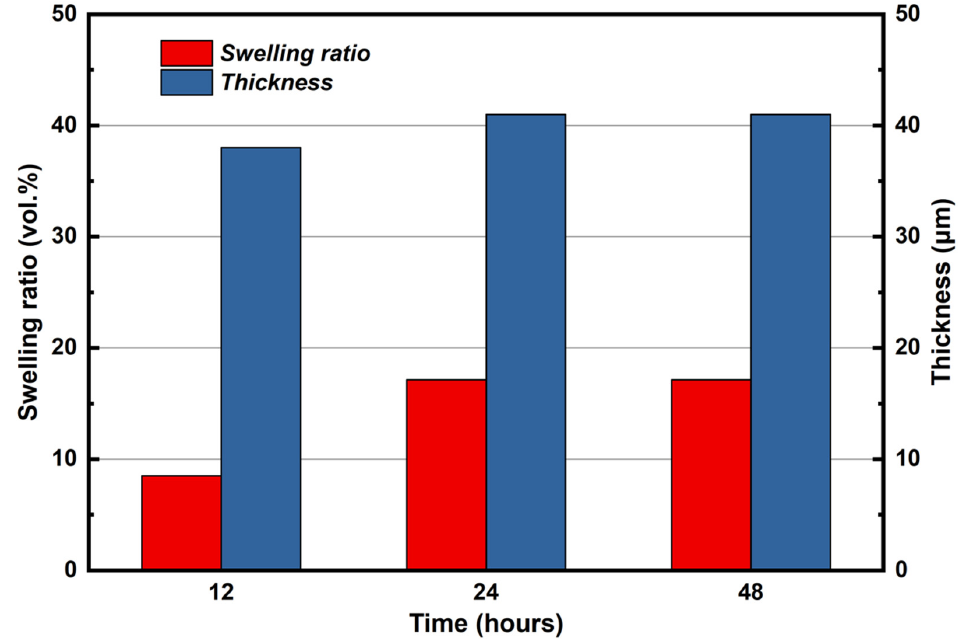
Figure 3. The thickness and the swelling ratio of KH 5 (PO 4 ) 2 -doped PBI membrane changing with doping time. doping